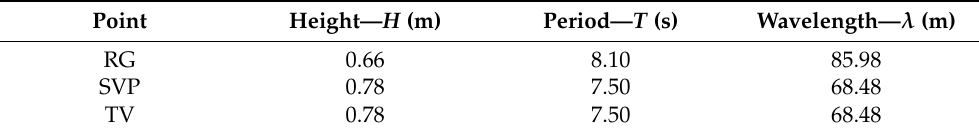
Table 1. Characteristics of representative regular waves.